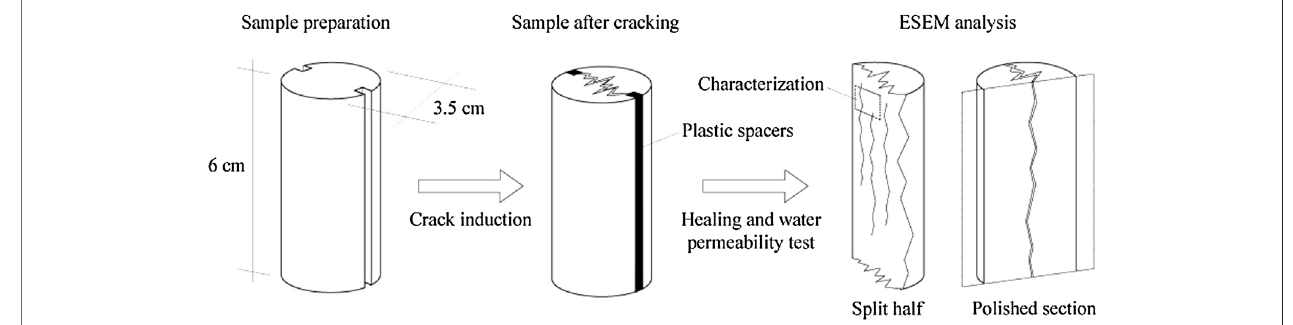
TABLE 6 | Amount of separate components included in each fl ask analyzed through non-invasive oxygen sensors.